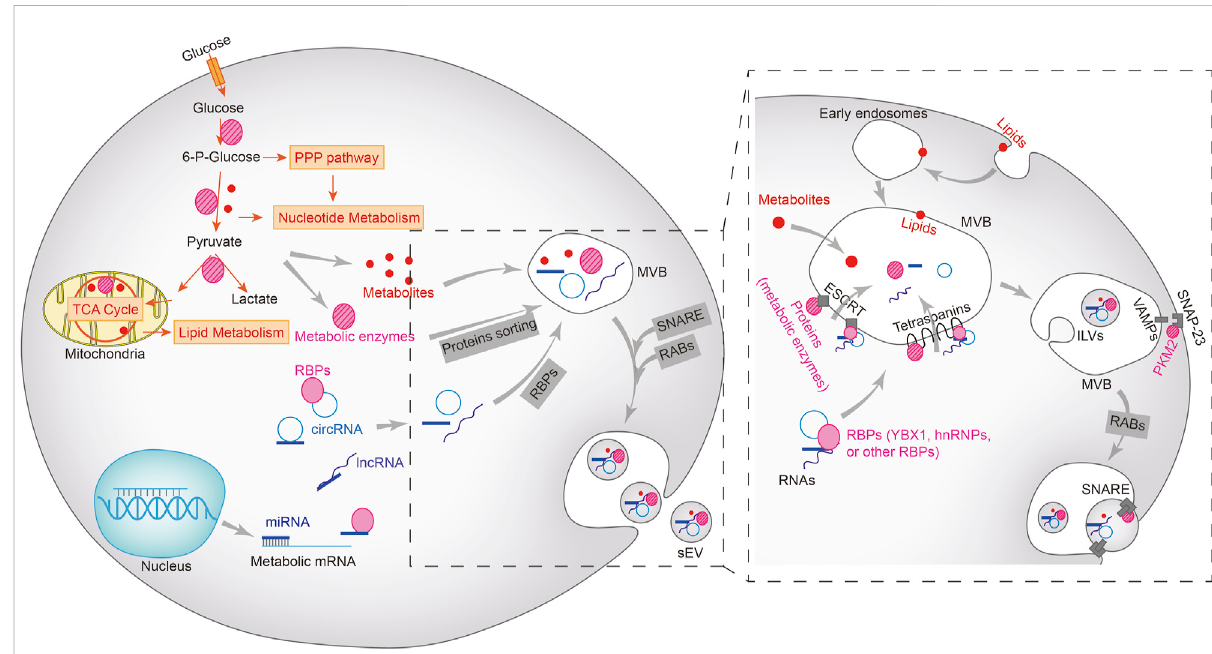
FIGURE 1 Metabolic cargoes insEVs andtheir packaging, sorting andbiogenesis. Metabolicenzymes andotherregulatoryproteins,metabolites,miRNAs, lncRNAs, and circRNAs are sorted into multivesicular bodies (MVBs) in different ways and subsequently excretes from the cells via the vesicle secretion pathways. Lipids (including phospholipids, sphingolipids, or triglycerides) on the plasma membrane enter MVBs via the early endosomes, but the sorting mechanism of other metabolites remains unclear. Proteins, including metabolic enzymes as well as RNA-bound RNA binding proteins (RBPs) enter the MVBs through ESCRT-dependent or independent mechanisms. The intraluminal vesicles (ILVs) in MVBs bind to the plasma membrane to form SNARE complex, which facilitates the extracellular release of